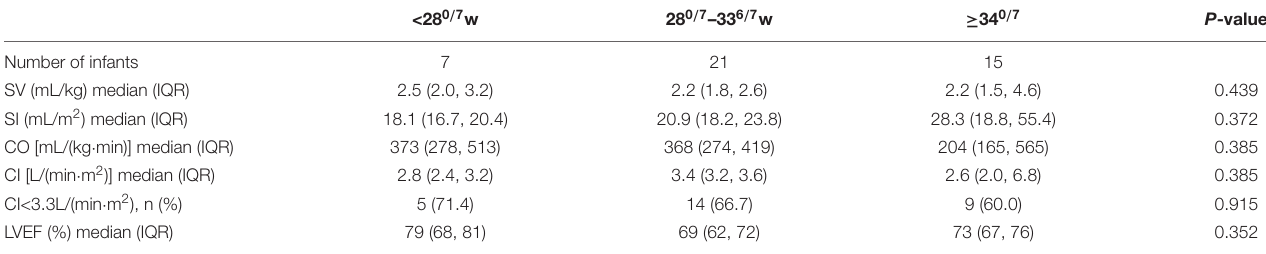
TABLE 2 | The baseline values of LV systolic functional parameters in preterm infants with septic shock at the different gestational age-stratified distribution. <28 0 / 7 w 28 0 / 7 –33 6 / 7 w